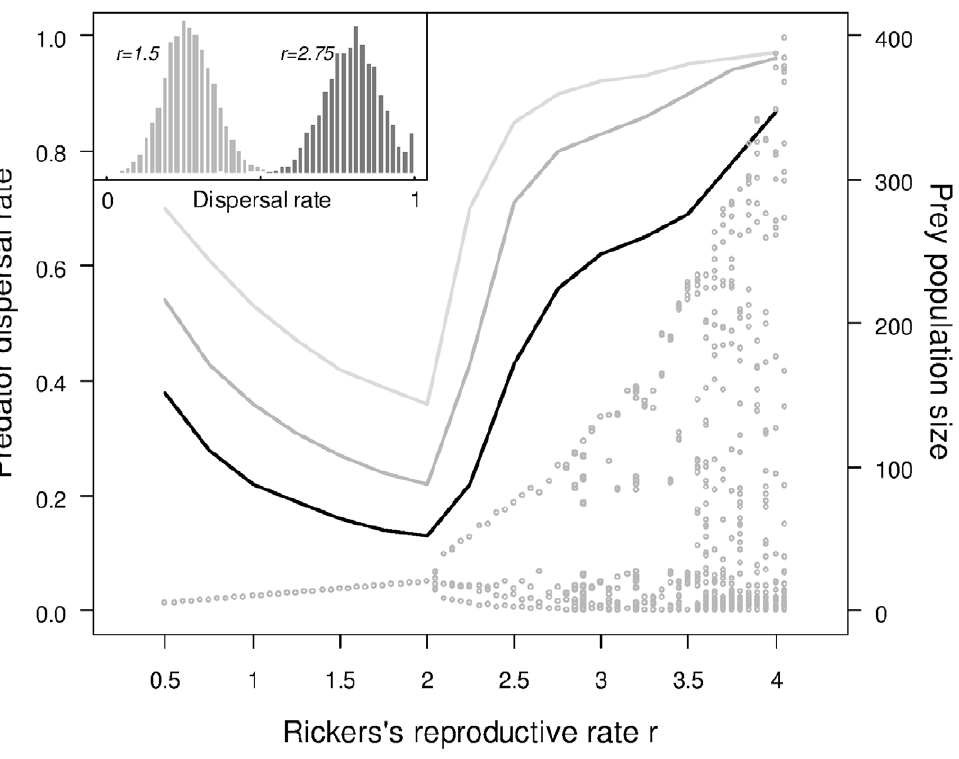
Figure 1. Evolution of predator emigration probability. Average predator emigration probabilities obtained after the model stabilized (left y- axis) for a range of r between 0.5 and 4.0 (by increments of 0.5). The three lines represent three different mortality costs of dispersal imposed on predators (from light grey to black: c =0.05, 0.1, 0.2 respectively, see Methods). The bifurcation diagram shows the distribution of stable limits of the prey dynamics for the range of r values (right y-axis).The extent of variation in predator emigration probability at the population level is shown for two sets of simulations in the inserted panel (cost of dispersal c =0.1 for both).